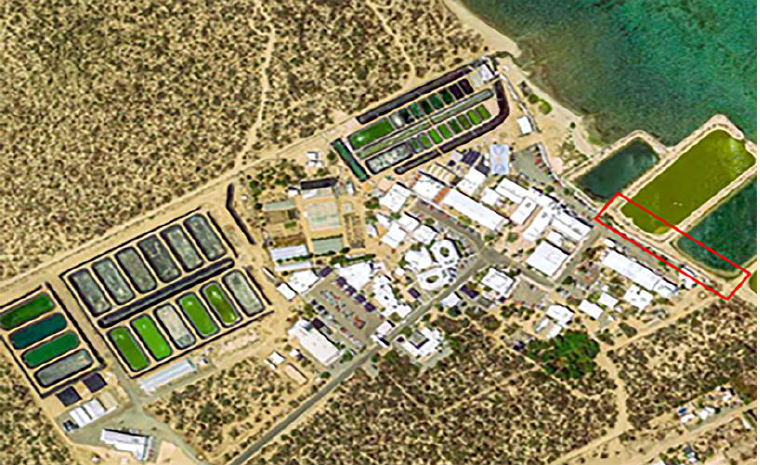
Figure 1. Satellite image from the Center for Biological Research of the Northwest M é xico S.C. (CIBNOR), the red area indicates the seed collection area of Salicornia bigelovii (Torr.).